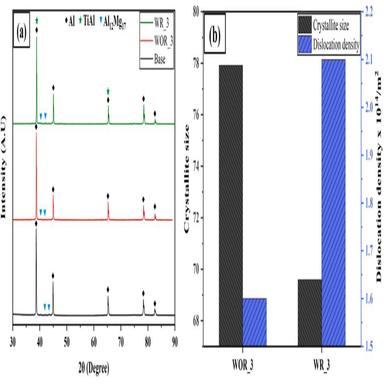
(a) XRD plot of all material conditions. (b) variation in crystallite size and dislocation density for WOR_3 and WR_3 materials.